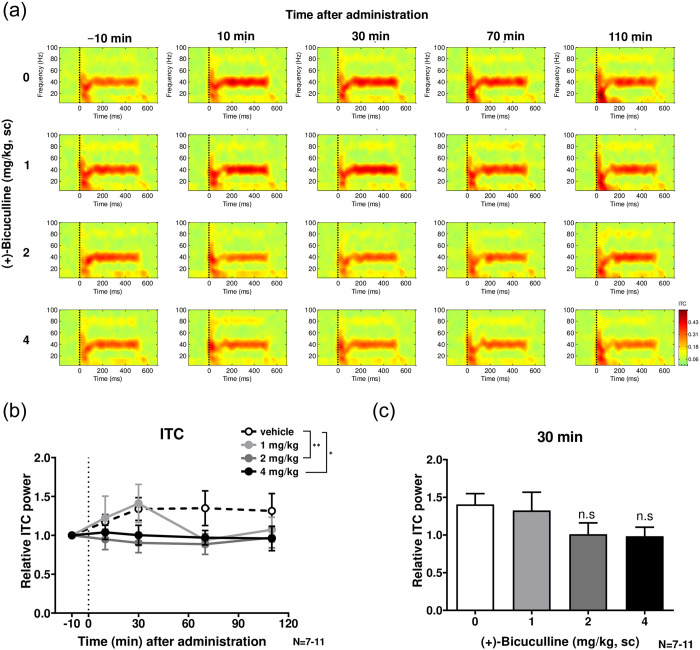
The effect of (+)-bicuculline on the 40 Hz ITC.a, Heat map representation of mean time-frequency plots of ASSR at 40-Hz stimulation at −10 (baseline), 10, 30, 70 and 110 min following (+)-bicuculline (0, 1, 2 and 4 mg/kg, sc) treatment, as shown for ERSP in Fig 2. b, Time-course of the 40 Hz ITC following (+)-bicuculline treatment. The 40 Hz ITC was significantly reduced in bicuculline (2 and 4 mg/kg)-treated rats than vehicle-treated rats. c, Effect of bicuculline on the 40 Hz ITC at 30 min, the time at which bicuculline achieves Cmax. No statistically significant effect was observed on ITC with bicuculline treatment. Values are mean ± SEM. The number of rats was 12 in each group.